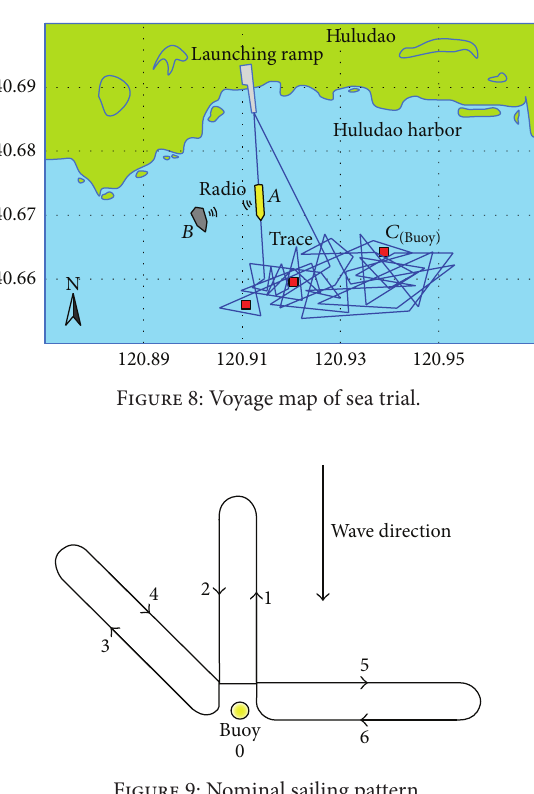
Figure 9: Nominal sailing